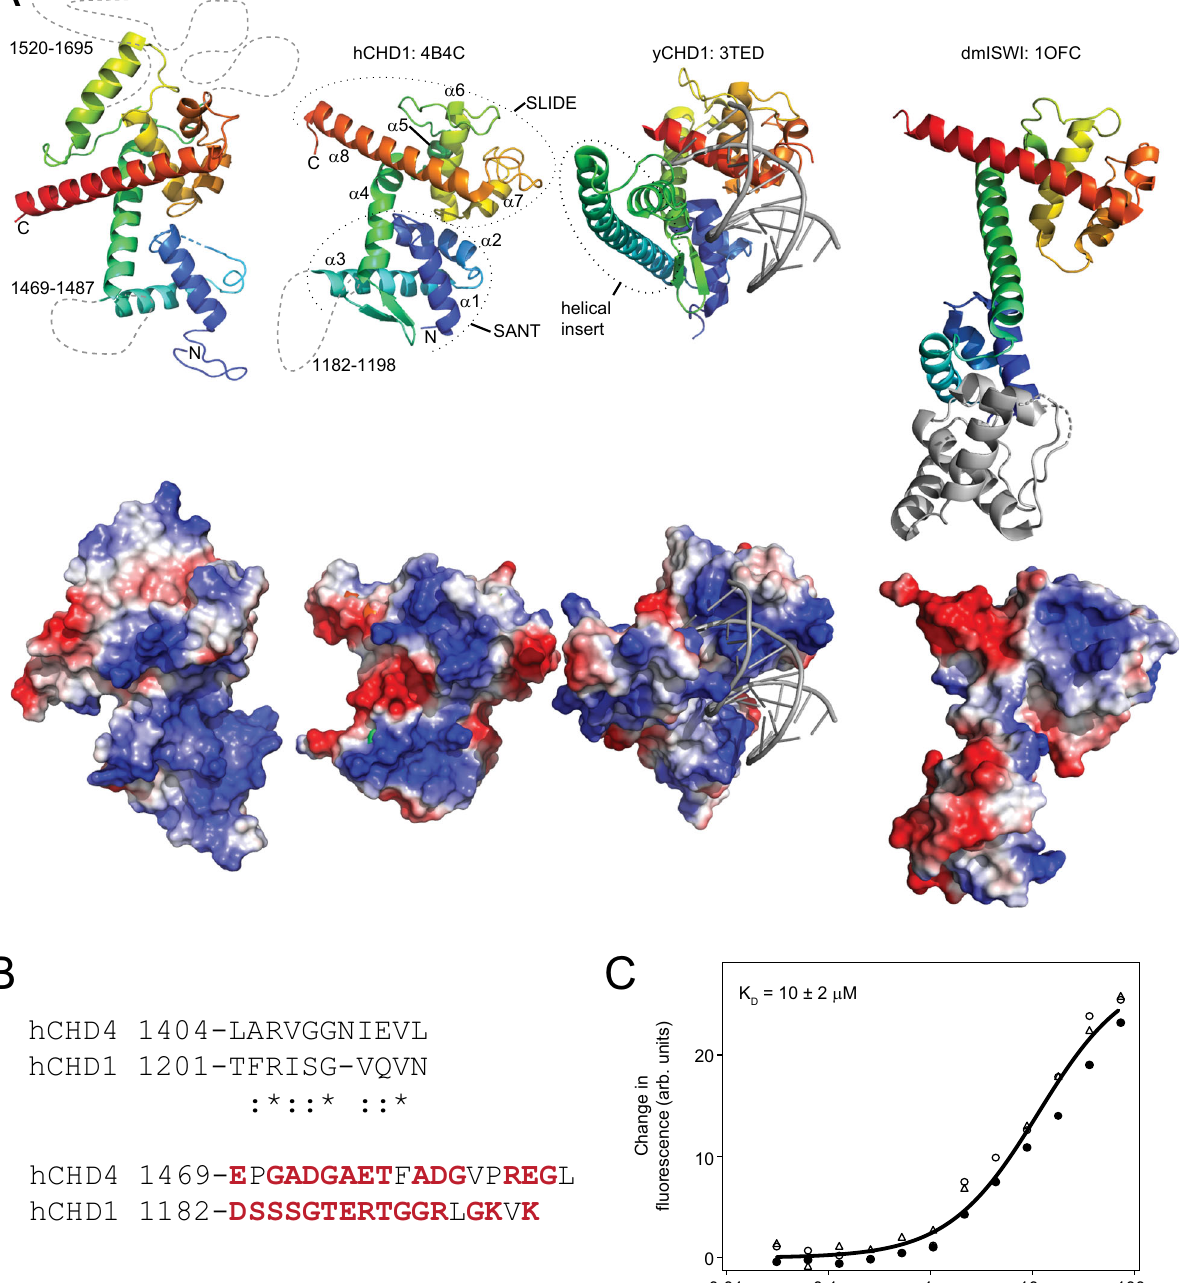
Fig. 5 | The C1aC2b region contains a SANT-SLIDE domain that can bind DNA. A Left . X-ray crystal structure of C1bC2a- Δ 139 (PDB 8D4Y). X-ray crystal structures of the SANT-SLIDE domains of human CHD1 (PDB: 4B4C), yeast CHD1 bound to DNA(PDB 3TED 27 ), andthe HAND-SANT-SLIDEdomain of Drosophilamelanogaster ISWI (PDB 1OFC 28 ) are also shown. In all cases, the ribbon diagram is coloured as a rainbow from N- to C-terminus ( blue to red ) and positions and loops for which no electron density was observed are indicated as dashed lines (approximately to scale). Electrostatic surfaces (computed in PYMOL) are shown below each struc- ture. The HAND domain of dmISWI is shown in grey . B Top . Sequencealignment of